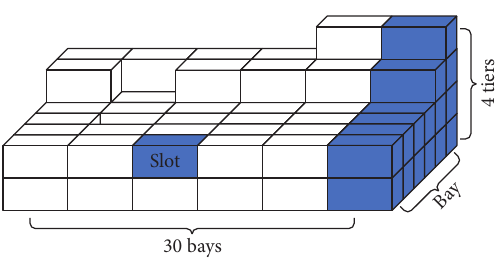
Figure 3: The schematic diagram of a